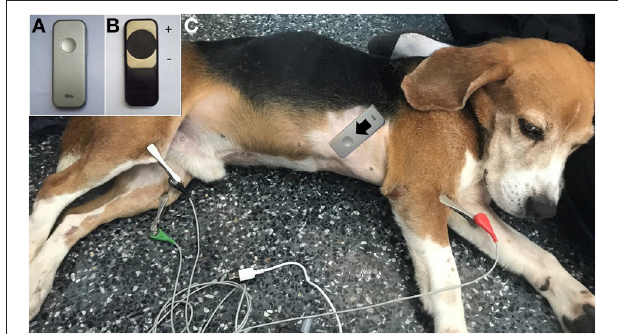
FIGURE 2 | The Eko® DUO ECG + Stethoscope device in the top view (A) and bottom view (B) is labeled with positive and negative electrodes. The placement of the device in a dog at the right skin thorax at the direction from base to the apex of the heart (C) .